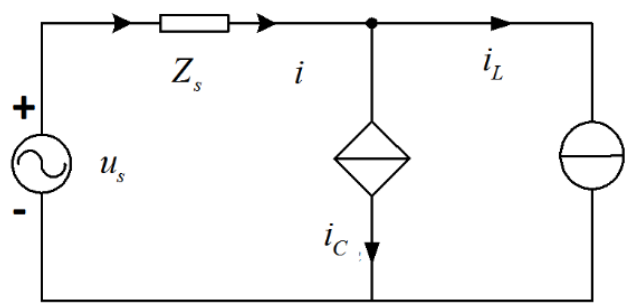
Figure 2. The schematic of direct current control for SVG.